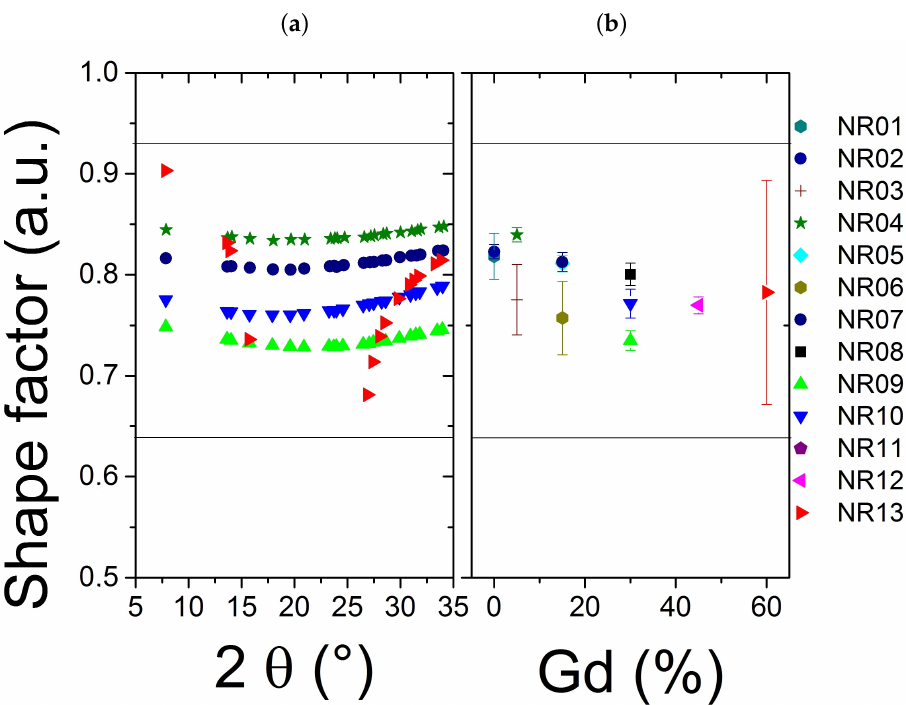
Figure 5. ( a ) Shape factor for each peak of four typical samples (NR04, NR07, NR09, NR10) and the most different sample (NR13) ( b ) Mean shape factor versus the expected gadolinium concentration.